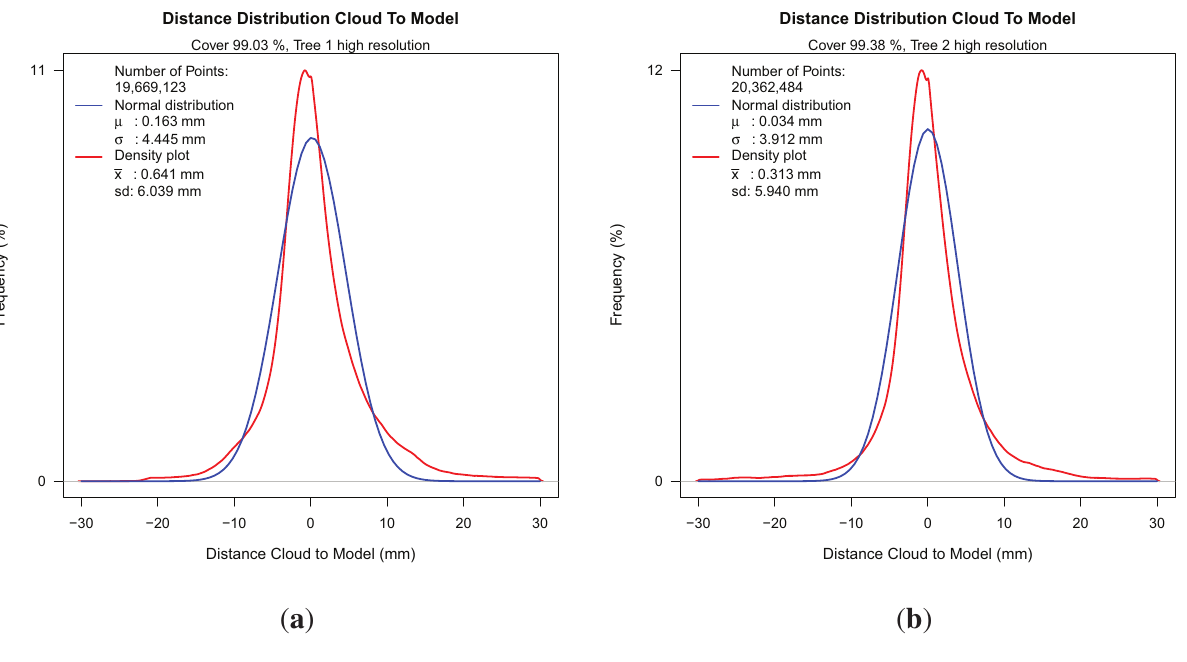
Figure 6. Distance histogram with fitted normal distribution for both Group II point clouds: (a) distance histogram for Tree 1; (b) distance histogram for Tree 2.